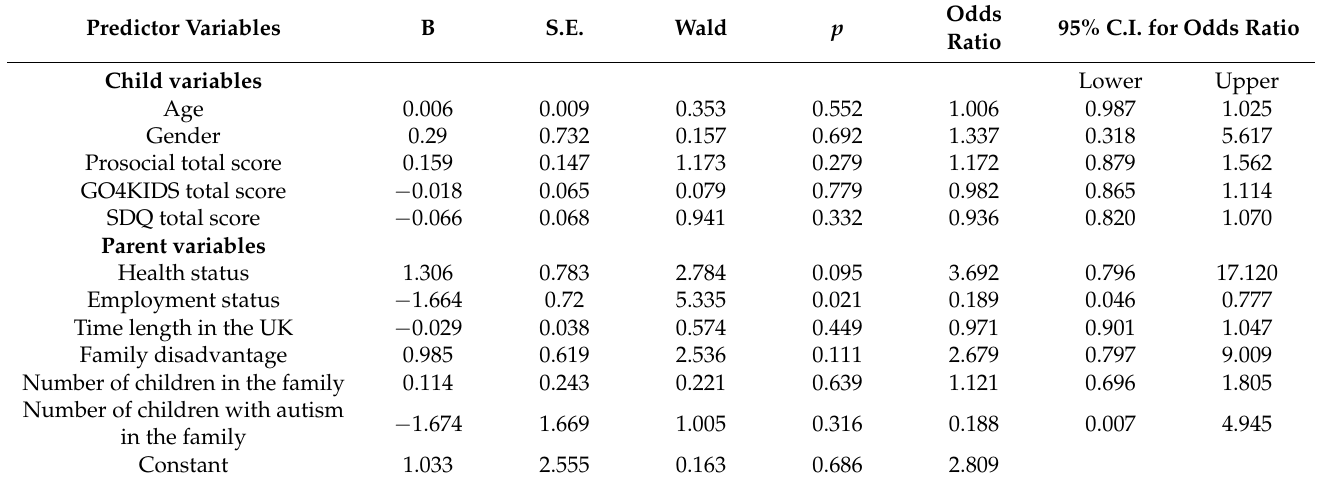
Table 4. Results of logistic regression analysis predicting parental relationship